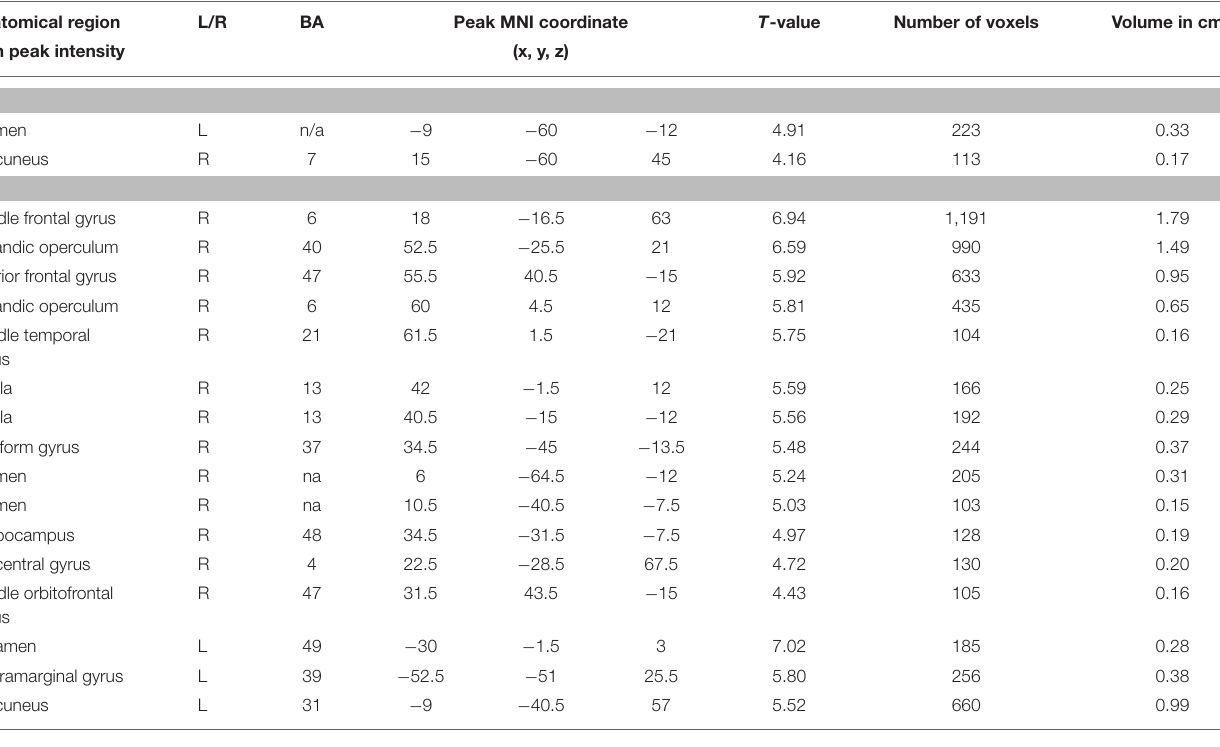
TABLE 1 | Brain areas showing a significant positive correlation of BOLD signal with (A) alpha band peak frequency and (B) alpha PSD (FDR corrected, p < 0.05, T < 3.44, cluster threshold > 100). Anatomical region L/R BA Peak MNI coordinate T -value Number of voxels Volume in cm 3